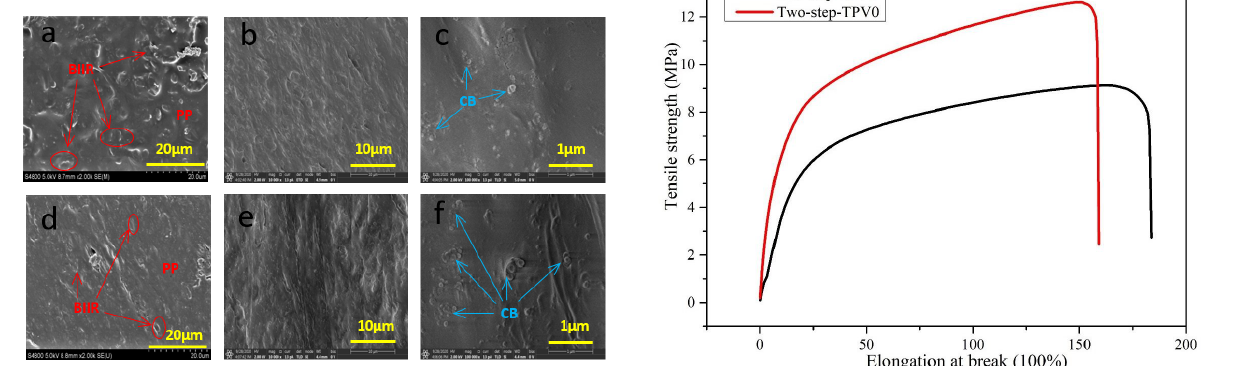
Figure 3: Tensile stress-strain curves of one-step-TPV0 and two-